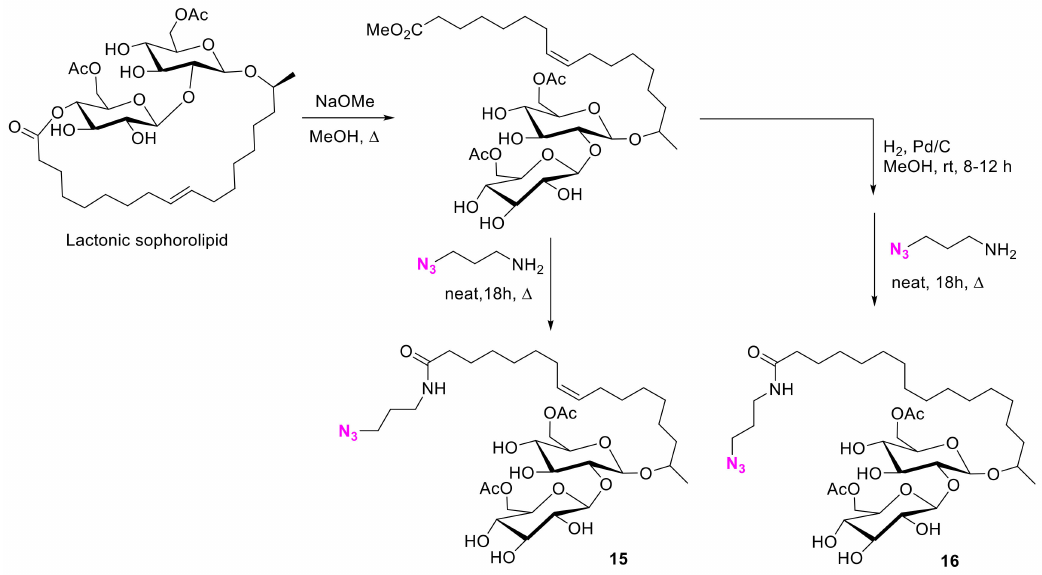
Scheme 17. Synthesis of glycolipid surfactants’ moieties 15 and 16